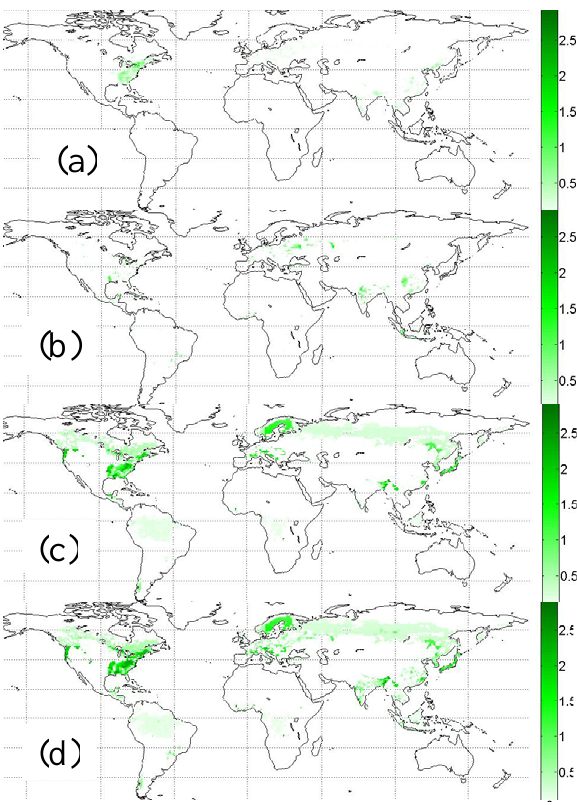
Figure 1. The distribution of secondary forest area Fig. 1. The distribution of secondary forest area (10 9 m 2 ) re- abandonment, (b) pastureland abandonment, (c) wood harvest , and (d) sum of (a), (b) grown from (a) cropland abandonment, (b) pastureland abandon- and (c). ment, (c) wood harvest, and (d) sum of (a), (b) and (c).